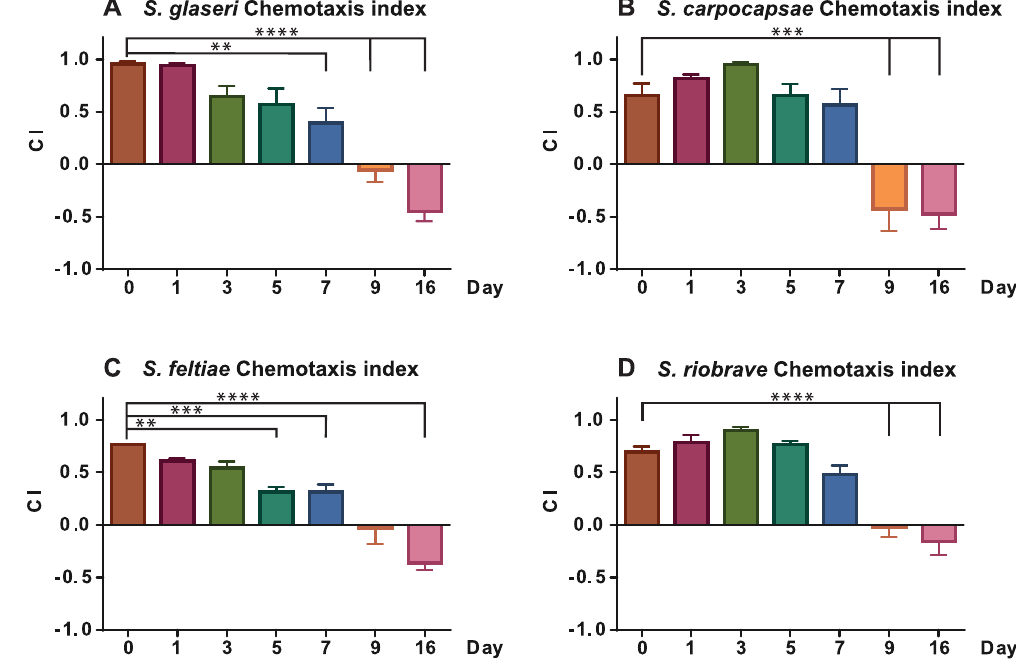
Figure 2. Chemotaxis indices shown for the four species of Steinernema EPN IJs. CI values near: + 1.0 indicate high attraction, near zero indicate indifference, and near − 1.0 indicate high repulsion. Statistical significance was evaluated using an unpaired, ordinary, one-way ANOVA with Tukey’s multiple comparisons post-test. Error bars represent SEM. ** P < 0.01; *** P < 0.001; **** P <